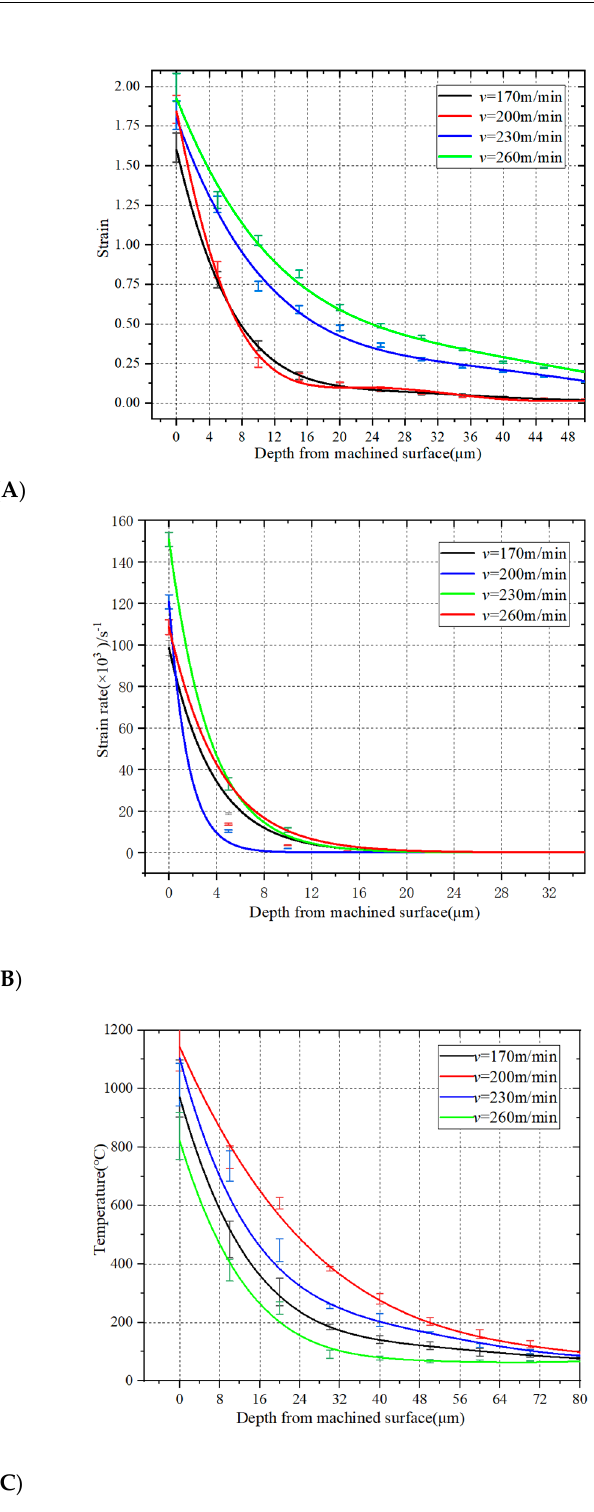
Figure 12. Effect of cutting speed on strain, strain rate, and temperature of machined surface. ( A ) Effect of cutting speed on strain of machined surface. ( B ) Effect of cutting speed on strain rate of machined surface. ( C ) Effect of cutting speed on temperature of machined surface.